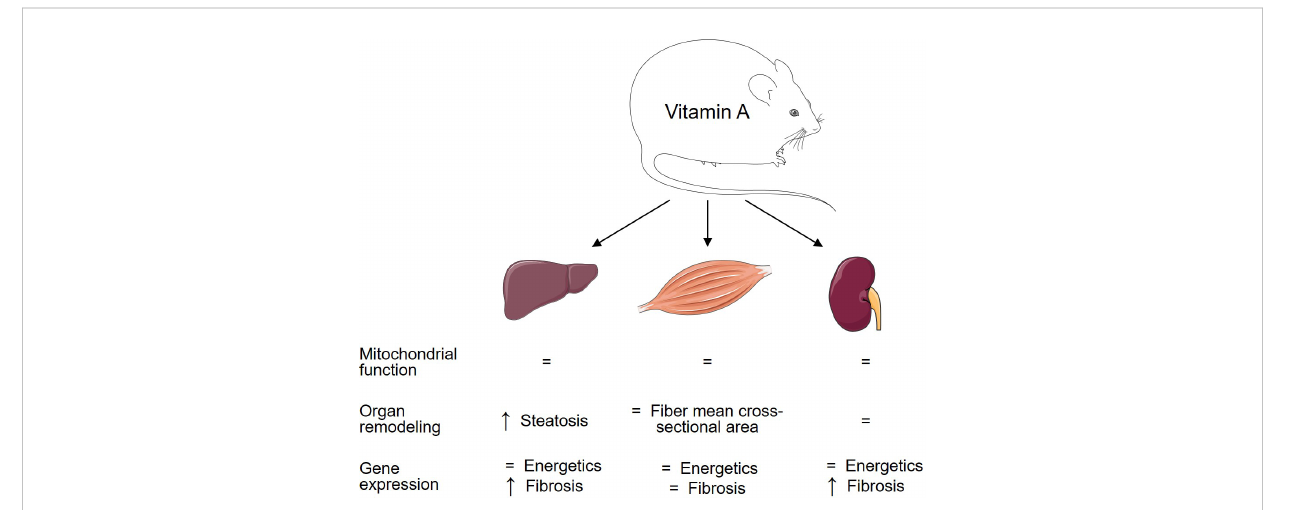
FIGURE 5 Tissue-speci fi c impact of VitA on mitochondrial energetics and tissue remodeling in DIO. Changes in the HFD relative to VAD HFD group are summarized to visualize the relationship between VitA content and tissue responses to HFD